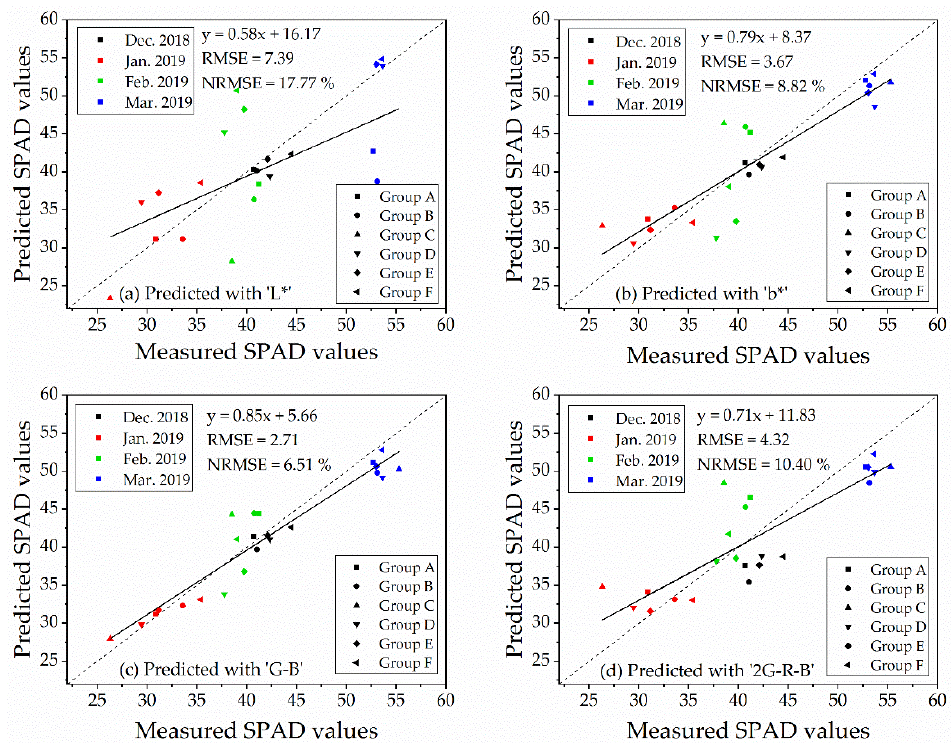
Figure 10. Validation of the four models for estimating of SPAD values at the flight height of 50.0 m (n = 23).